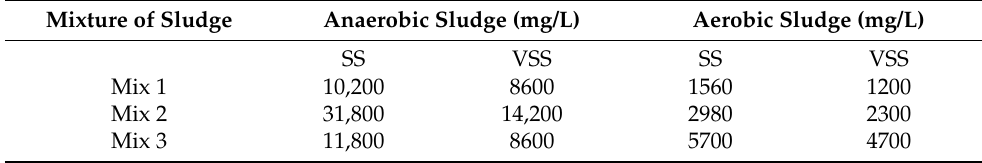
Table 2. Composition of sludge of Ube